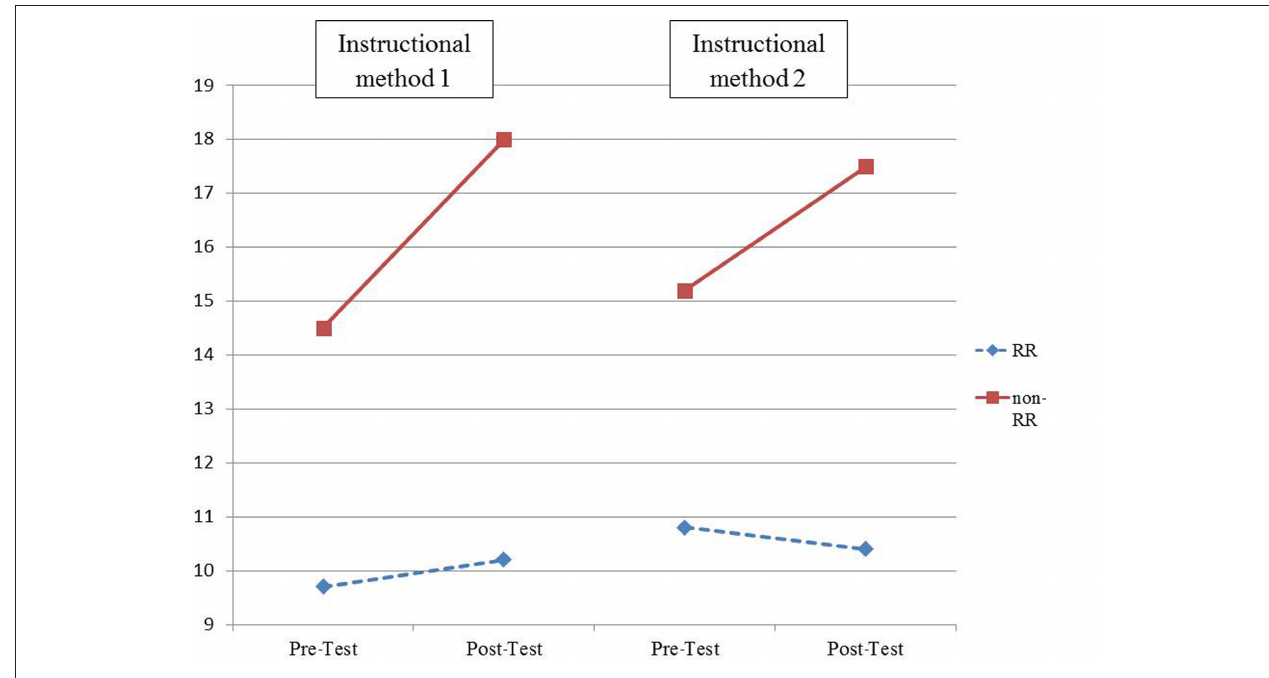
FIgure 1 | Differences in test score growth as a function of random responding status.